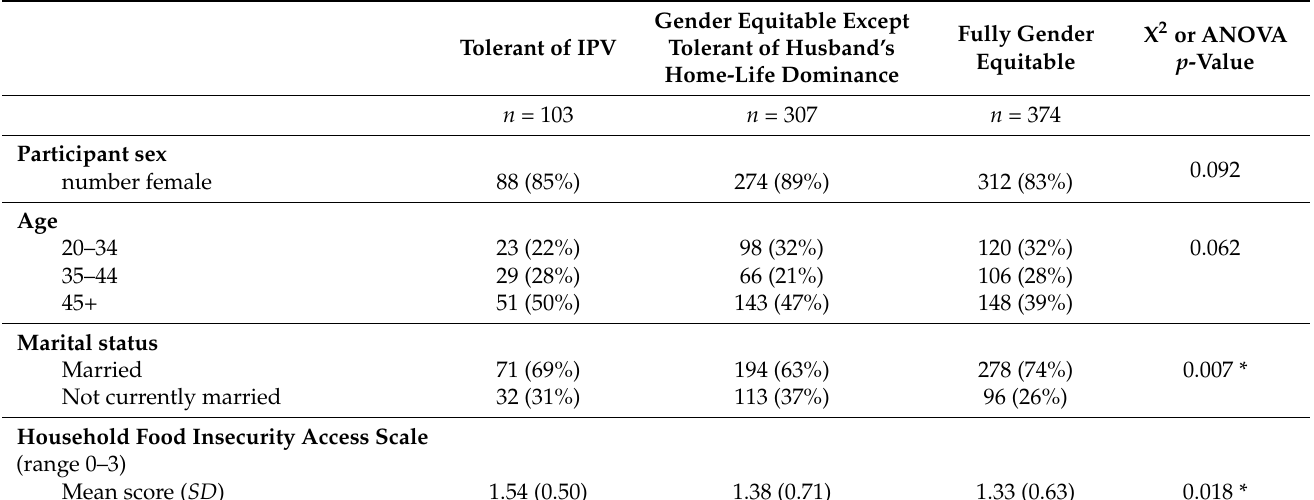
Table 3. Comparison of demographic characteristics by latent class.